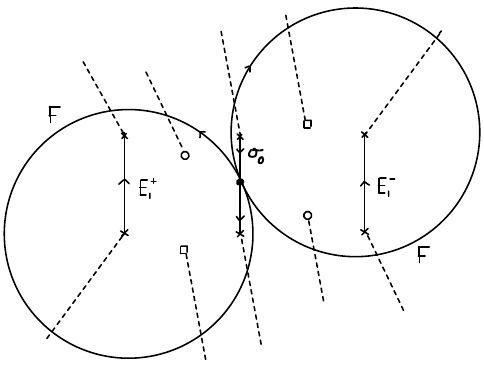
Figure 2 . The sum of cycles (cid:27) (cid:13) given by equation (A.1) represented as a sum of string junctions. The circle and square represent additional unspeci(cid:12)ed degeneration loci on the K 3 base. The black dot represents the orbifold (cid:12)xed